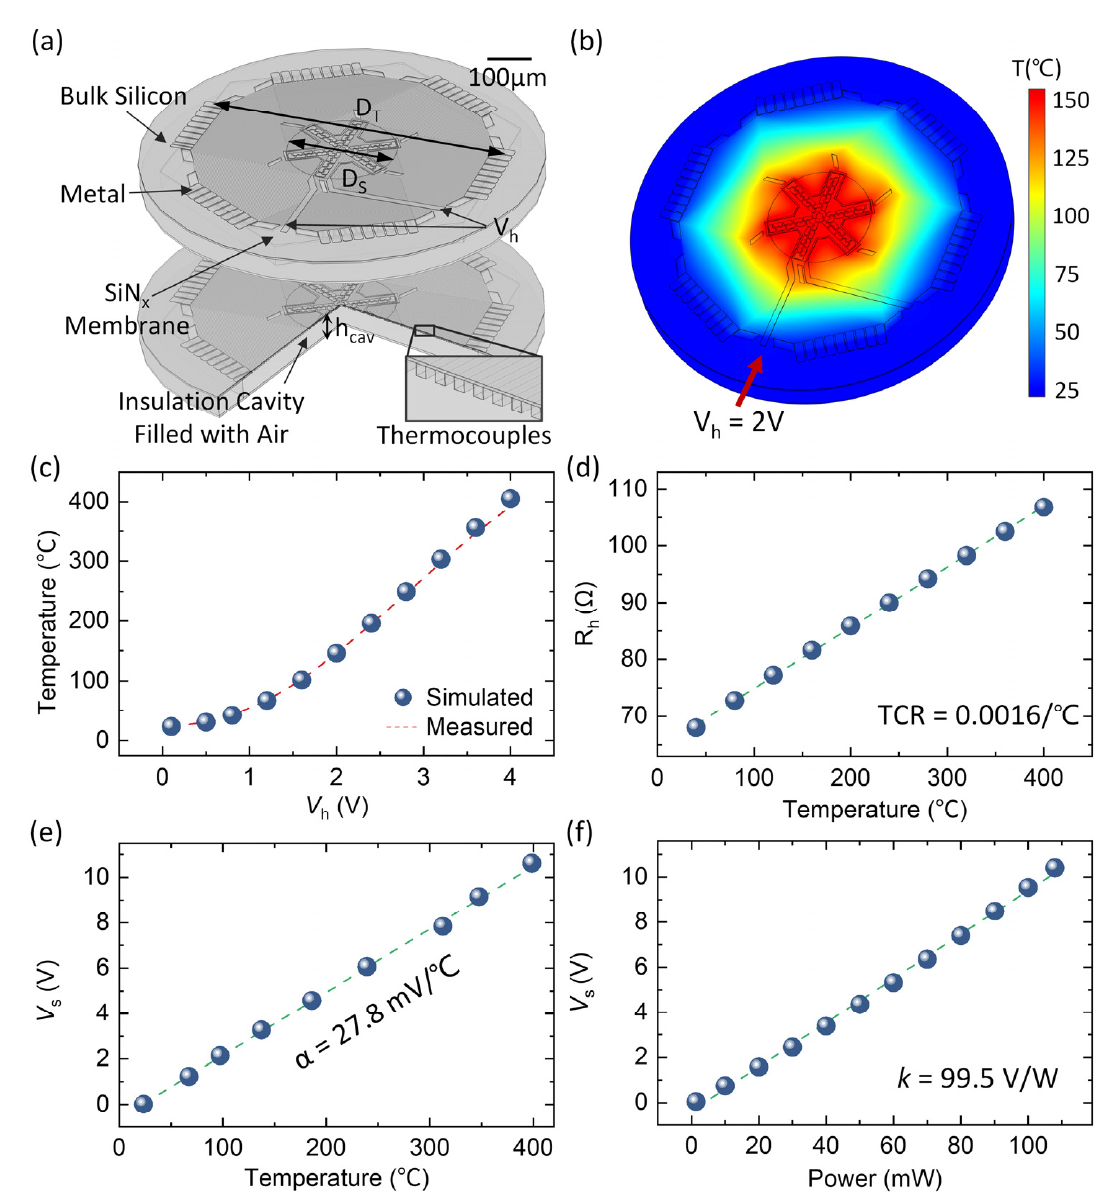
Figure 4. Thermal response of the MEMS thermopile chips. ( a ) The 3D model for finite-element simulation. ( b ) Temperature distribution at a heating voltage ( V h ) of 2V. ( c ) Heating voltage ( V h ) vs. the average temperature in the sample area. The measured results agree with the finite-element simulation results. ( d ) Measured heating resistance (R h ) vs. average temperature in the sample area, which indicates a TCR of 0.0016/°C. ( e ) The output voltage of the sensing thermopile ( V s ) vs. the average temperature in the sample area, which shows an ultra-high temperature responsivity of 27.8 mV/°C. ( f ) The output voltage of the sensing thermopile ( V s ) vs. the heating power, which shows an ultra-high power responsivity of 99.5 V/W.